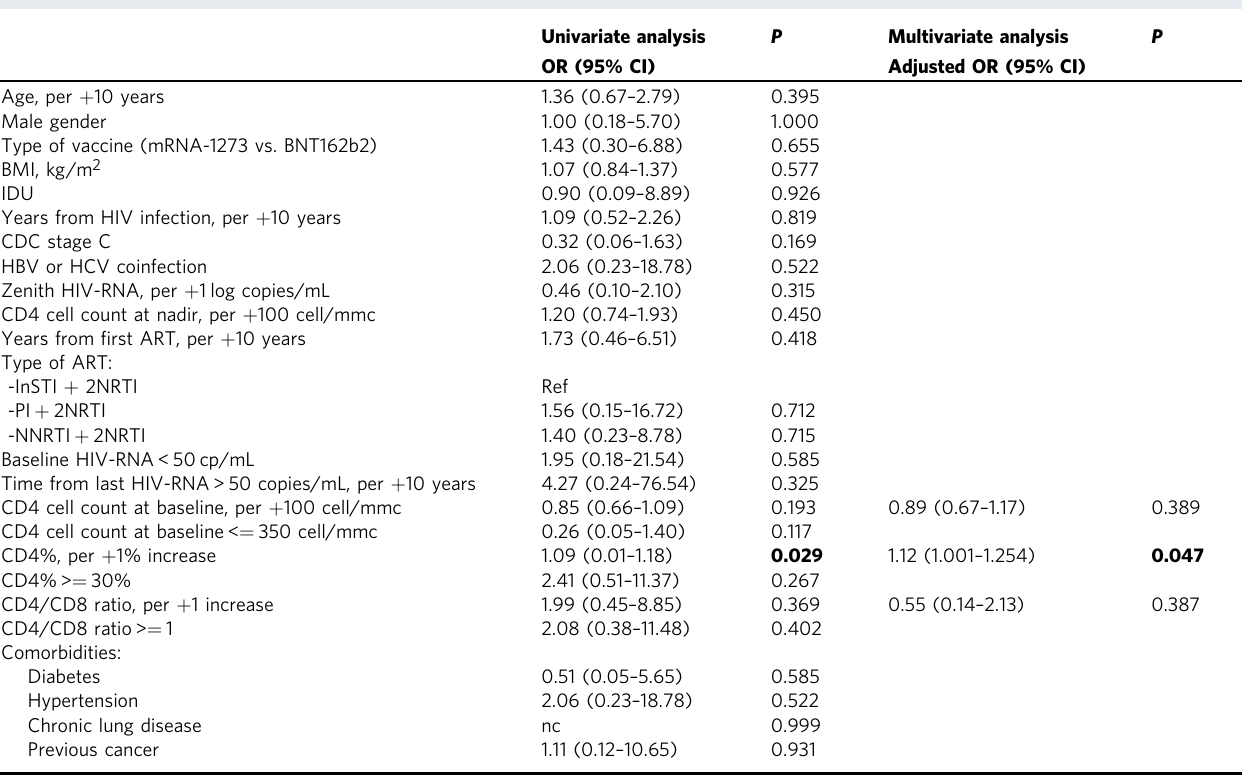
Table 2 Variables associated with the percentage of inhibition positive PLWHIV at 2 months post boost dose ( + 60 v2) (univariate and multivariate logistic regression